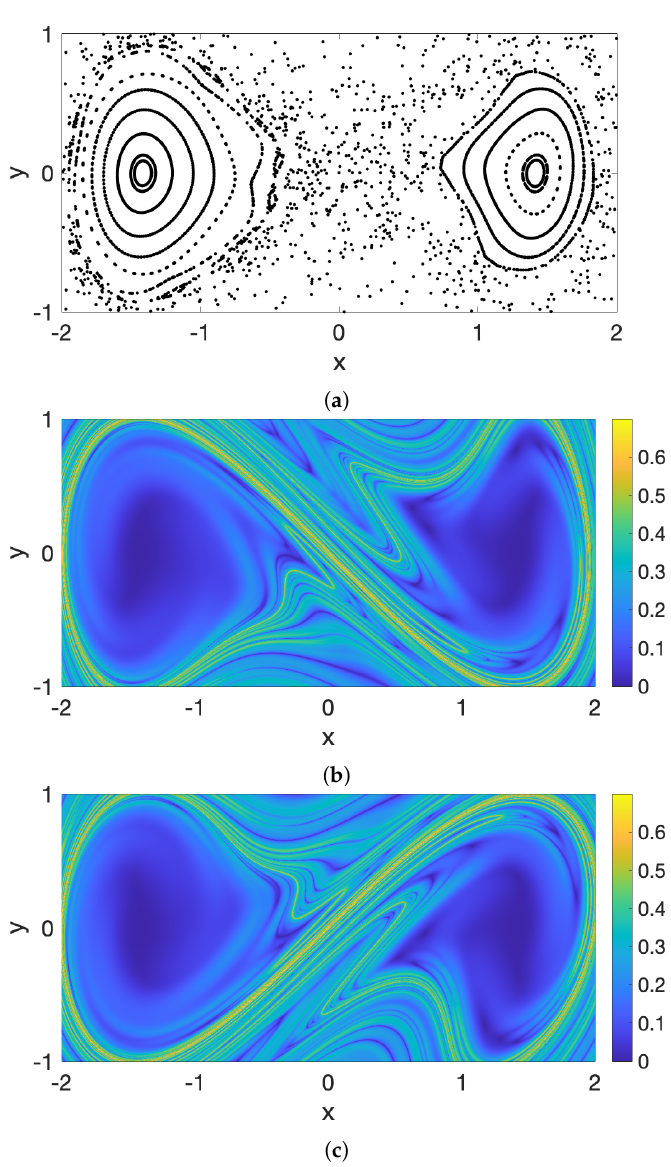
Figure 4. The asymmetric Duffing oscillator. ( a ) Poincaré map with 20 periods of perturbation T pert . ( b ) Forward- and ( c ) Backward- FTLE for 10T pert